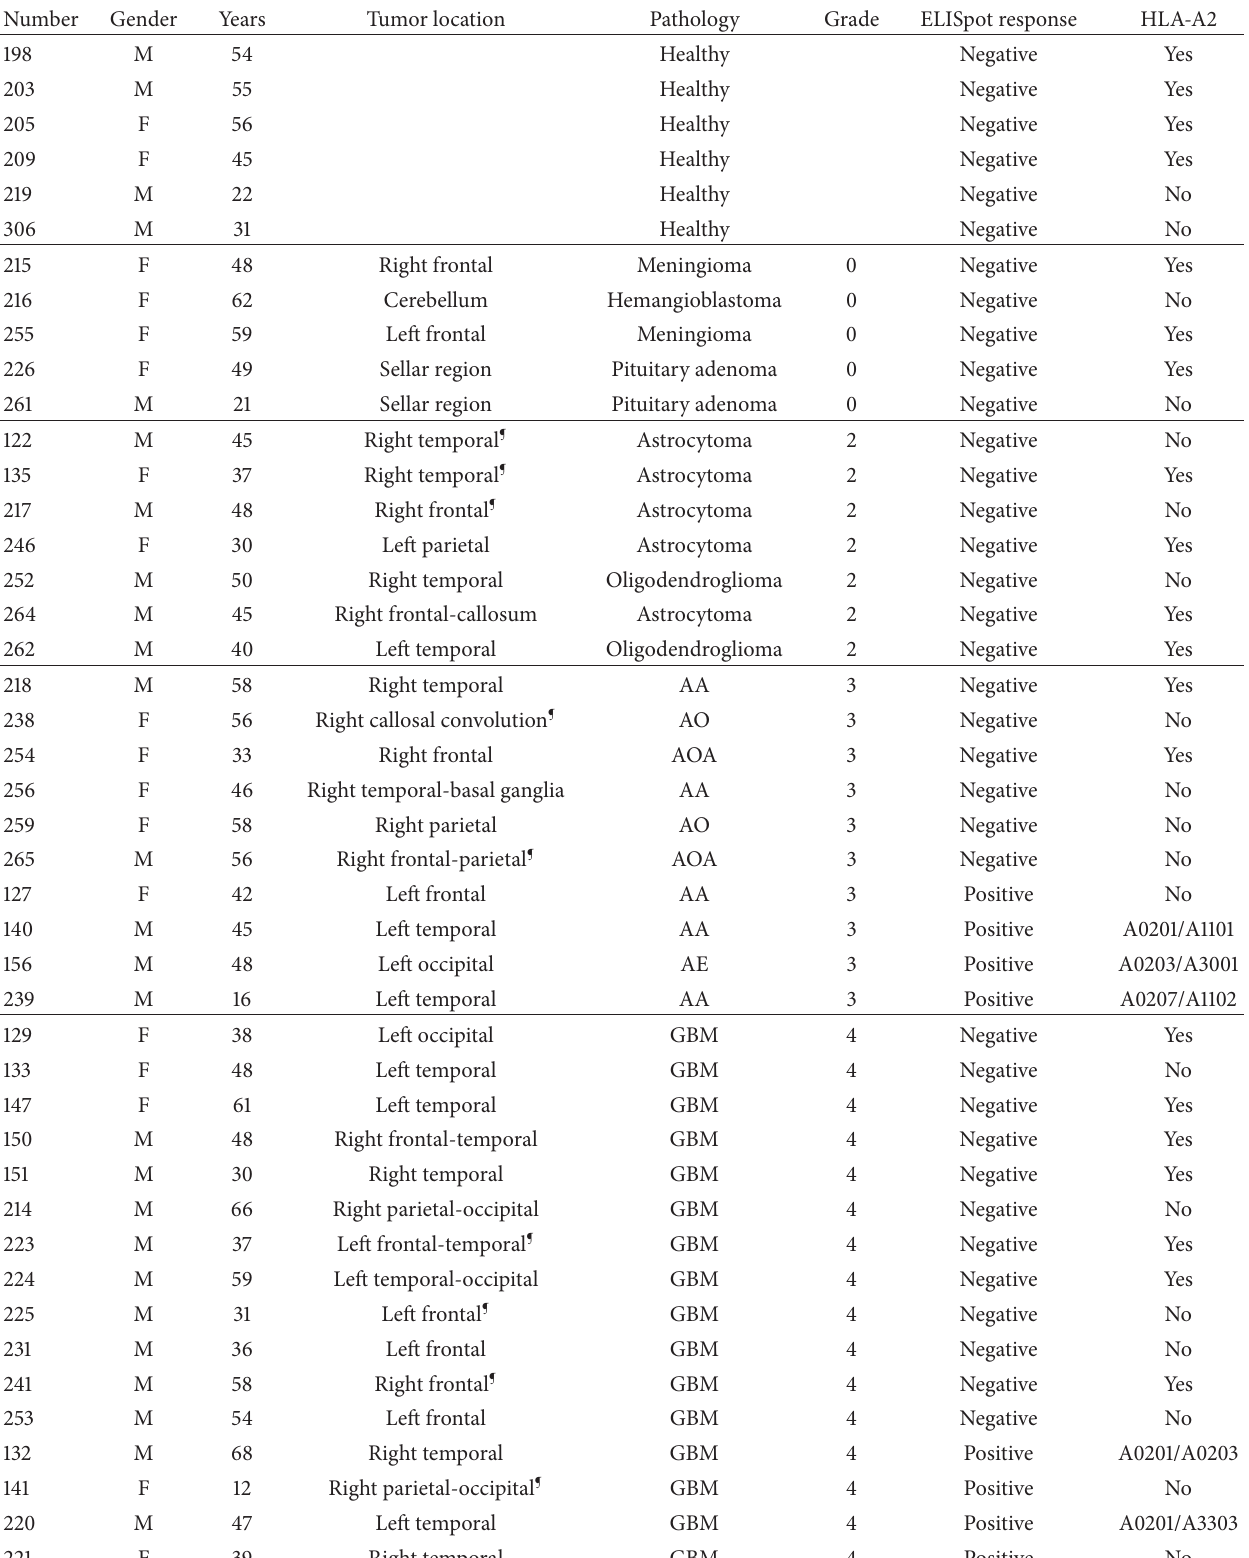
Table 1: Clinical characteristics of healthy donors and